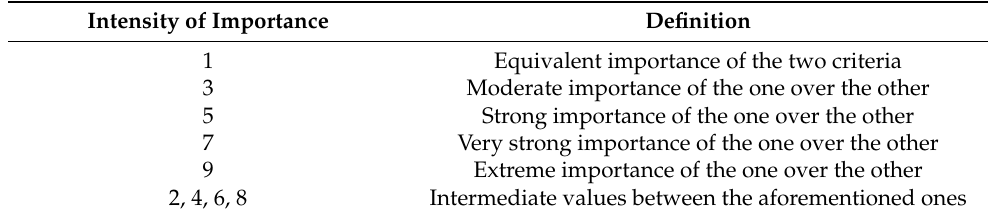
Table 3. Relative importance scale for the criteria.